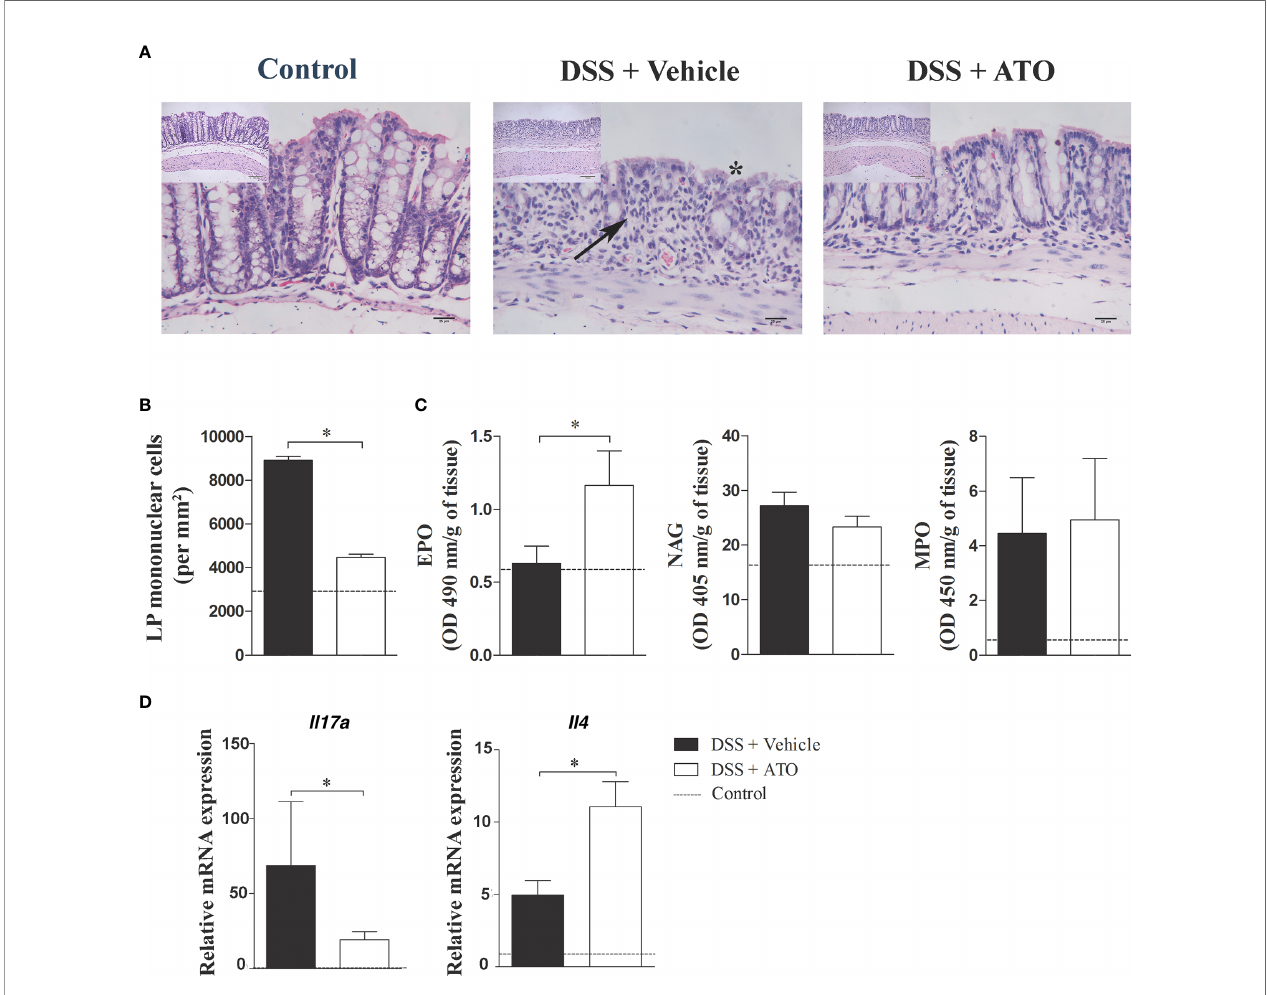
FIGURE 3 | ATO treatment improves the histopathological aspects of the colon, increases the eosinophil activity and IL-4 levels in the gut. C57BL/6 WT mice were exposed to 3% (w/v) DSS in drinking water for 6 days. Mice received oral treatment once daily for three days (days 3-5) with saline (vehicle) or 10 mg/Kg/day ATO. (A) Photomicrographs showing the histological analysis of colon. Asterisk indicates areas with absence of crypts. Arrows indicate cell in fi ltration in the LP. Original magni fi cation: 200x and 400x. (B) Number of mononuclear cells in LP per mm 2 of tissue. (C) Activity of EPO, NAG and MPO in colon. The results were expressed by OD (in nm) per gram of tissue. (D) Relative mRNA expression of IL-17A and IL-4 in colon. The dashed line indicates the values from healthy control mice without colitis induction. These results are representative of 2 or 3 independent experiments with 5 mice per group in each experiment. Unpaired t test or Mann-Whitney non-parametric t tests were used to determine if differences attained signi fi cant response. *p < 0.05. ATO, Atorvastatin; DSS, Dextran sodium sulfate; EPO, Eosinophil peroxidase; LP, Lamina propria; MLN, Mesenteric lymph nodes; MPO, Myeloperoxidase; NAG, N-Acetylglucosaminidase. OD, Optical